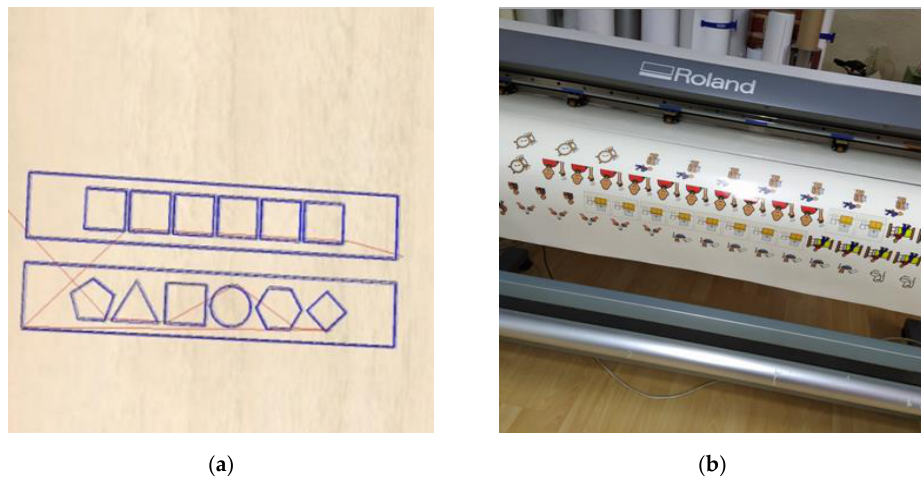
Figure 12. ( a ) Puzzles were designed with CorelDRAW ® software; ( b ) symbols are printed on a vinyl sticker.